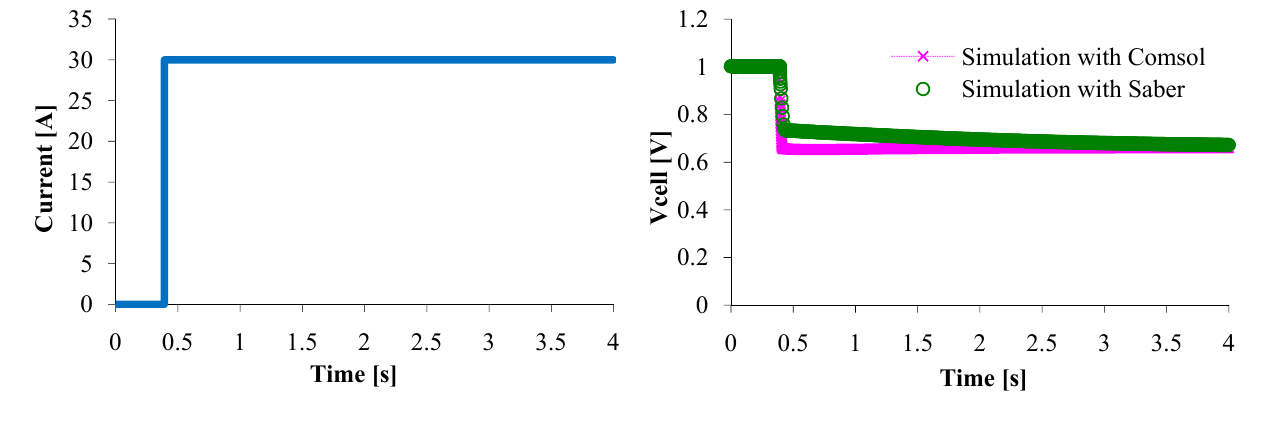
Figure 11. Voltage response to a current